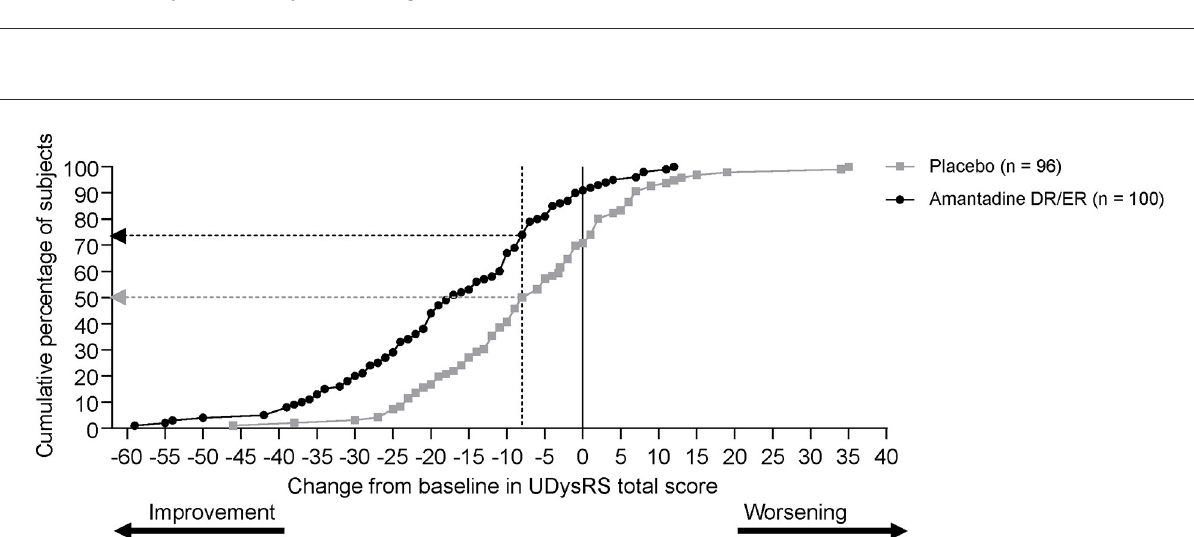
FIGURE3 Receiver operating characteristic curve (sensitivity vs. 1–specificity) for change in the UDysRS total score, using patient diary recording of ON time with troublesome dyskinesia ( 0.5-h decrease) as anchor [black line]. Actual change in UDysRS vs 1–specificity values [gray line] are also ≥ shown. 1–specificity values are shown as per the standard for ROC curves. LOCF, last observation carried forward; ROC, receiver operating characteristic; UDysRS, Unified Dyskinesia Rating